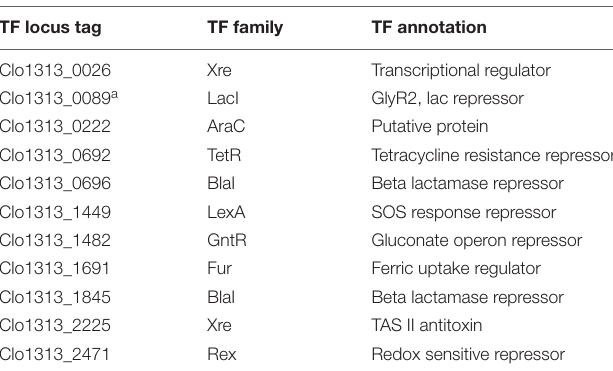
TABLE 1 | TFs with potential binding sites identified by